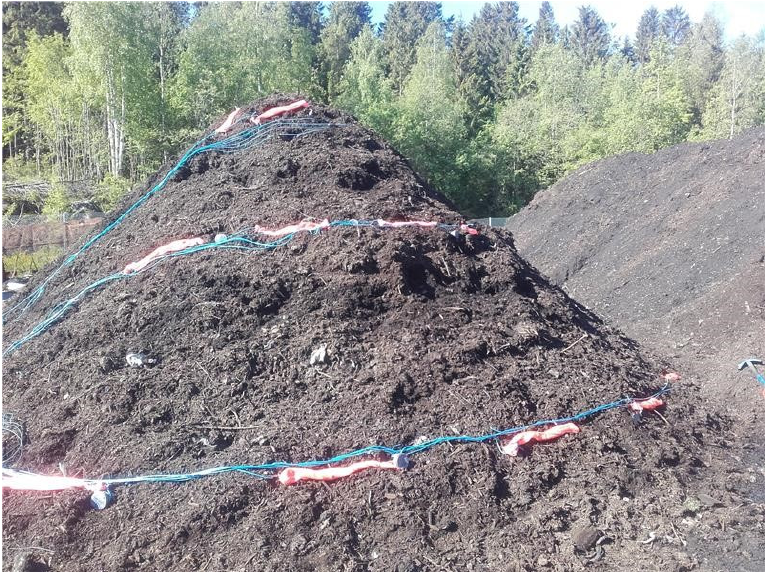
Figure 1. Four-month windrow composting experiment at the facilities of Mustankorkea Ltd. Seed samples were set inside small polyester bags and either a bigger polyester bag or a plastic capsule as part-samples. Temperature loggers were set inside the capsules and the samples were in three different layers. (Photo: Marjaana Hassani).